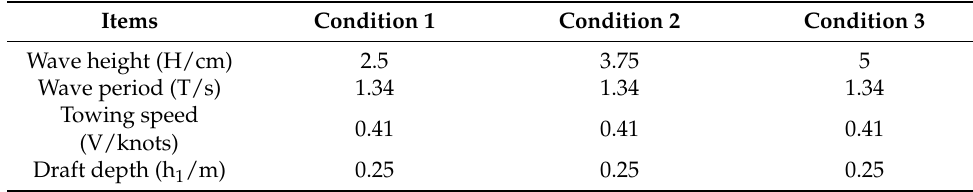
Table 9. Towing conditions of different wave